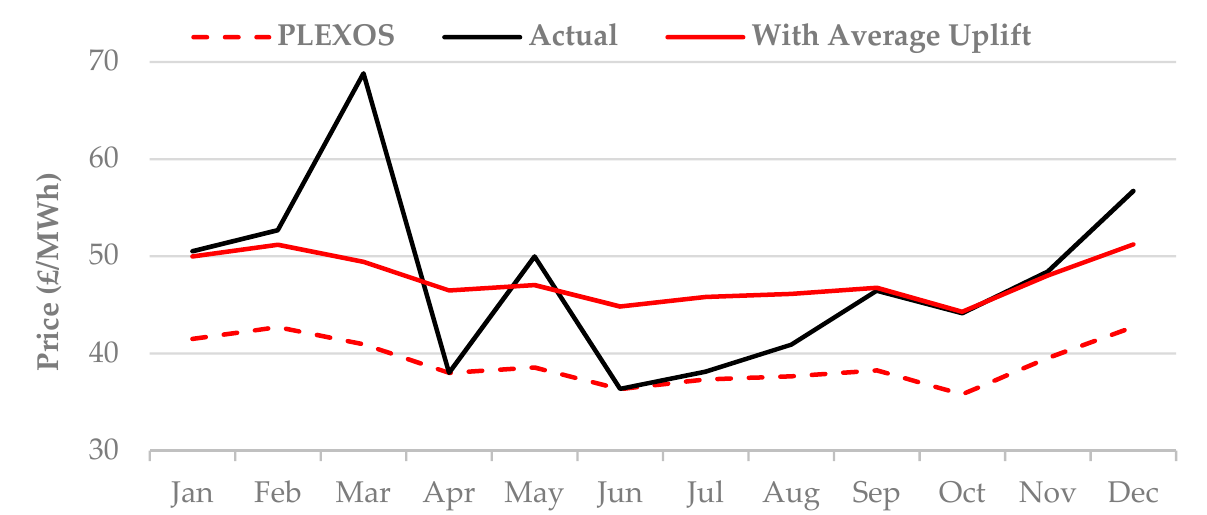
Figure 7. Monthly average electricity prices. The costs of generation do not include an uplift for long run marginal costs, so this is shown as the solid green line.